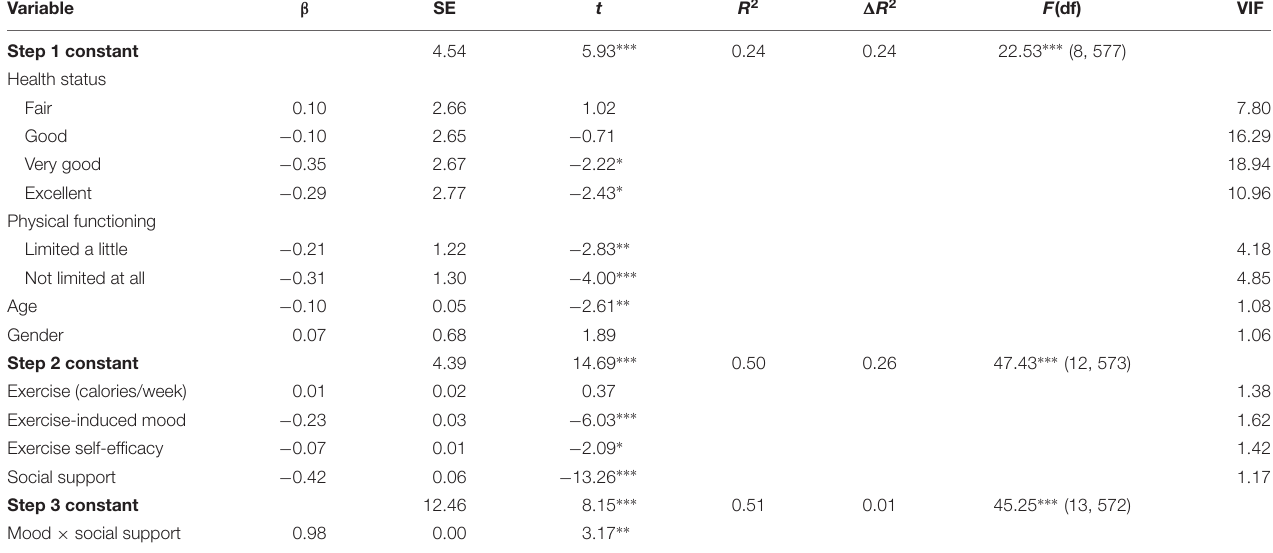
TABLE 3 | Hierarchical multiple regression analysis on depressive